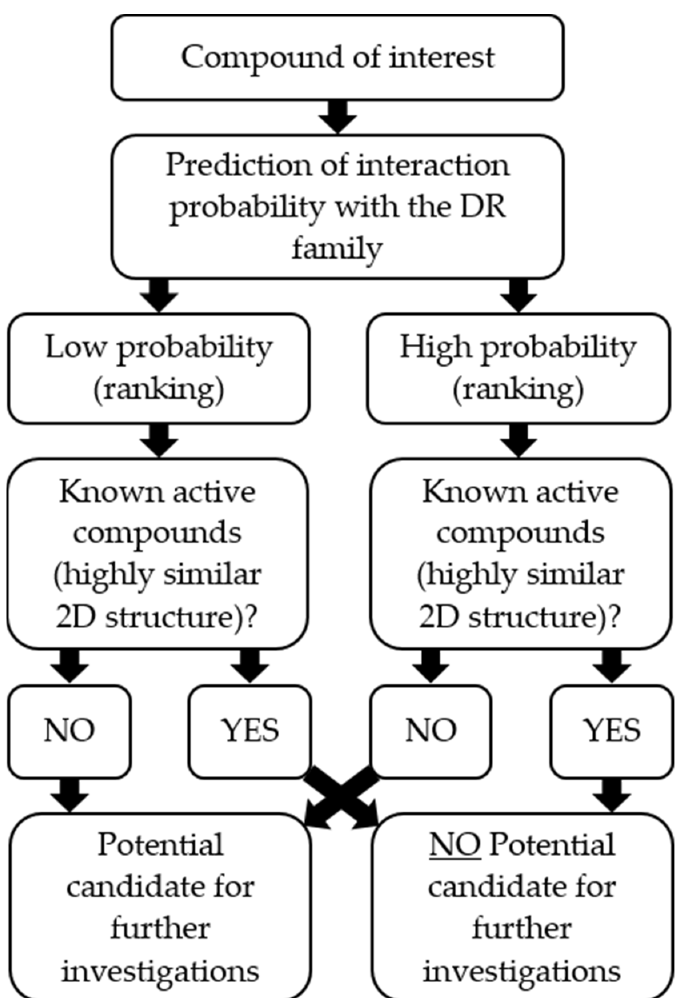
Figure 10. Decision tree following the investigation of the compounds of interest based on a Swis- sTargetPrediction search.